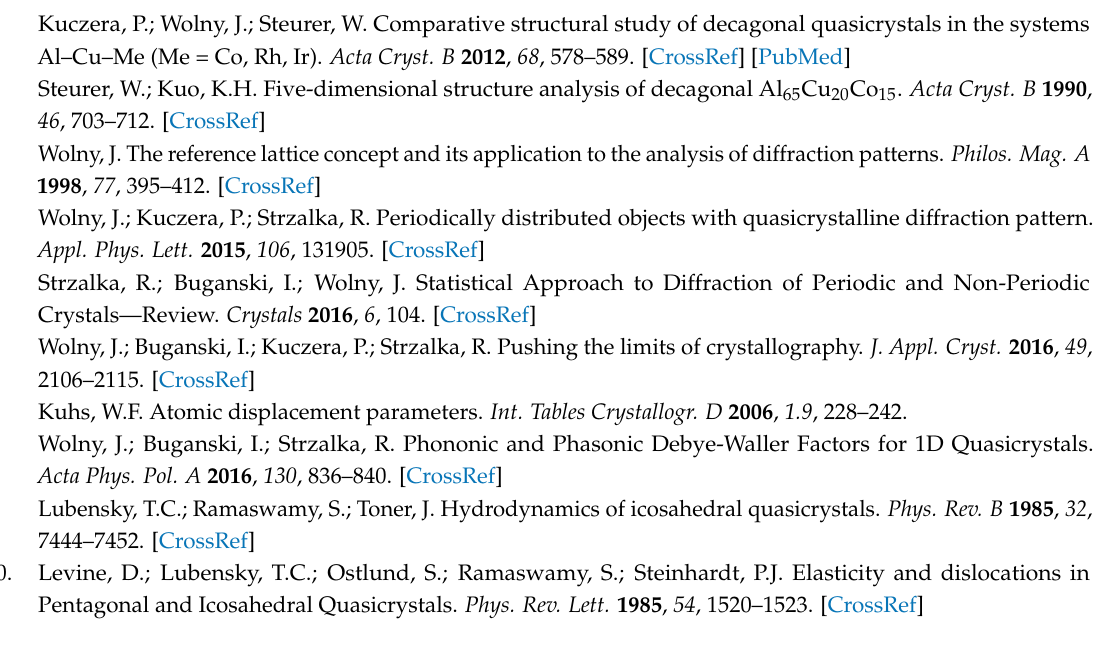
Table S1. Diffraction pattern of d -Al-Cu-Rh. List of 6 components of the scattering vector, parallel ( k x , k y , k z ), and perpendicular ( k xperp , k yperp , k zperp ), measured amplitudes (| F obs |), their uncertainties ( u (| F obs |)), calculated amplitudes (| F calc |), and extinction parameters (ext). Table S2. Atomic structure of d -Al-Cu-Rh. List of atomic positions ( x , y , z ) concentrations of elements ( p Al , p Cu , p Rh ), site occupation (sof), ADPs ( d xy , d zz ), and atomic fraction in unit rhomb (fraction). The last row shows the phasonic ADP ( b phas